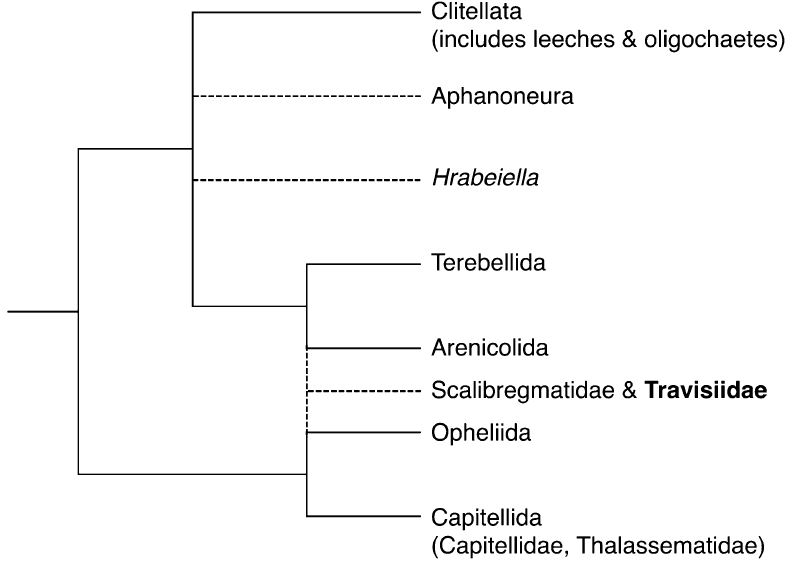
Figure 1. Phylogenetic relationships from a subset of Sedentaria modified from a metatree regarded as a working hypothesis for future studies by Struck 33 . Dashed lines indicate lineages with undetermined phylogenetic